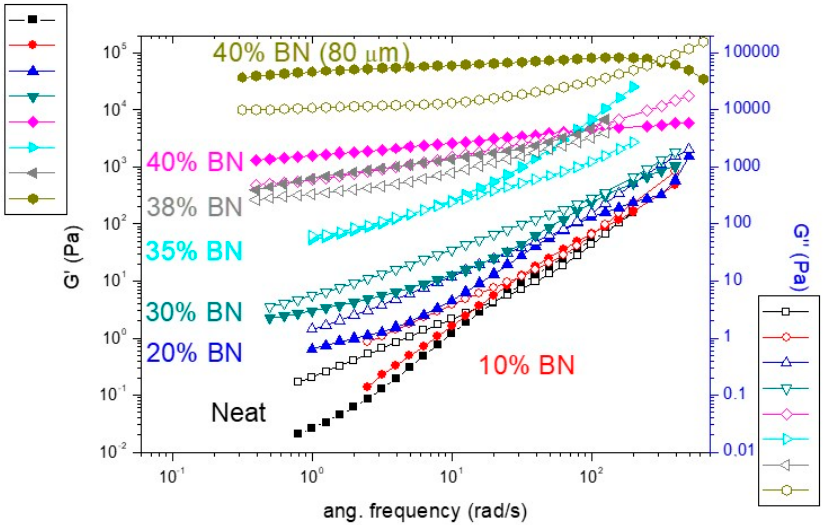
Figure 3. Plots of G ′ (filled symbols) and G ″ (open symbols) against ω for all the formulations at 30 °C.